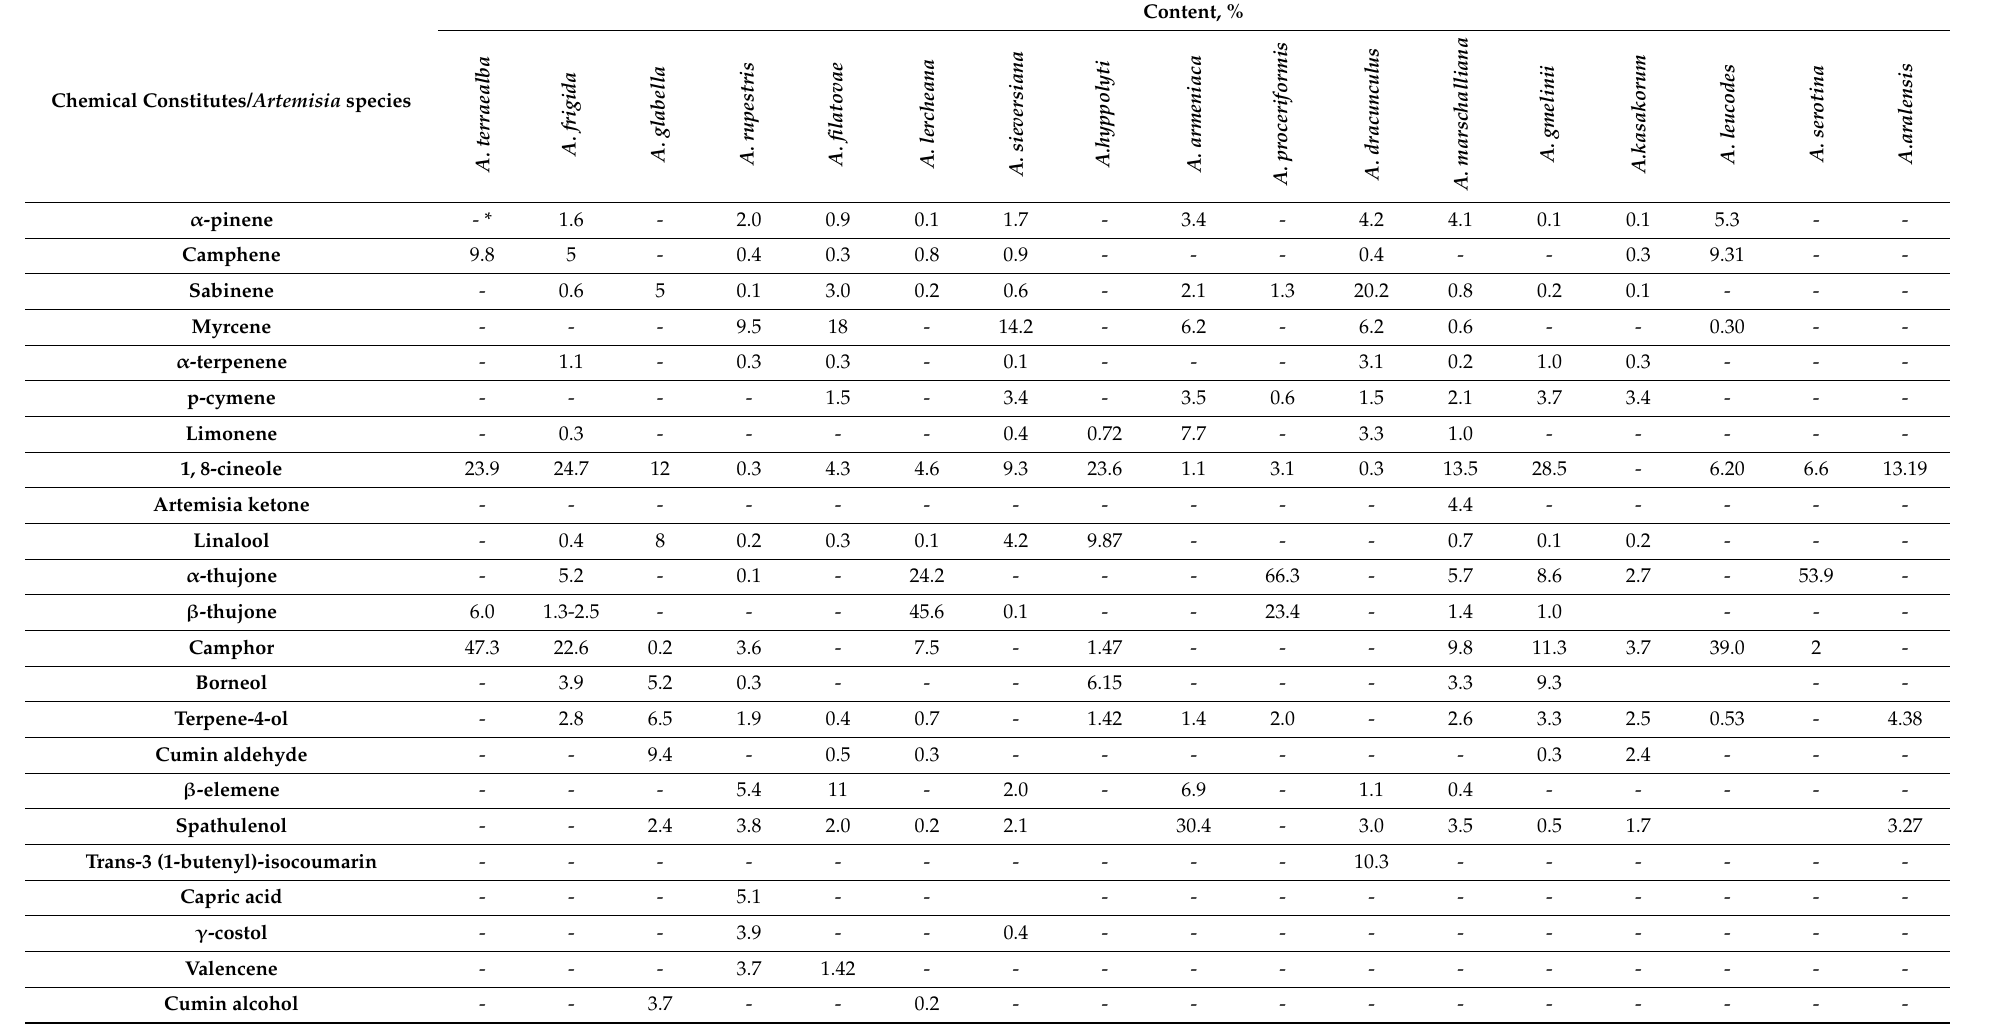
Table 2. Major components of essential oils from Artemisia species of Central Asia